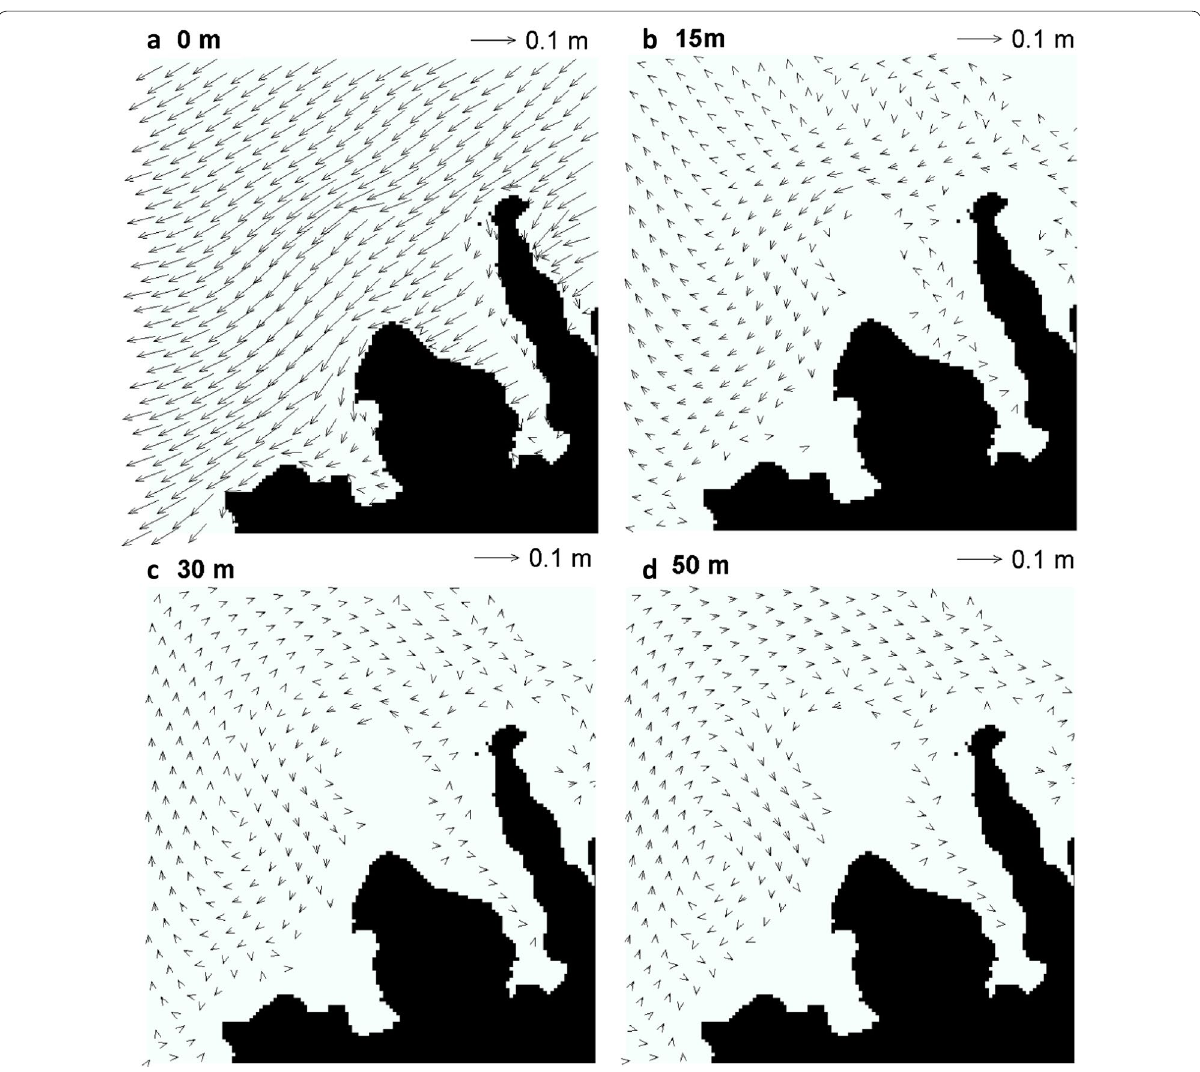
Fig. 7 Ocean current averaged in winter at depth of a 0 m, b 15 m, c 30 m, and d 50